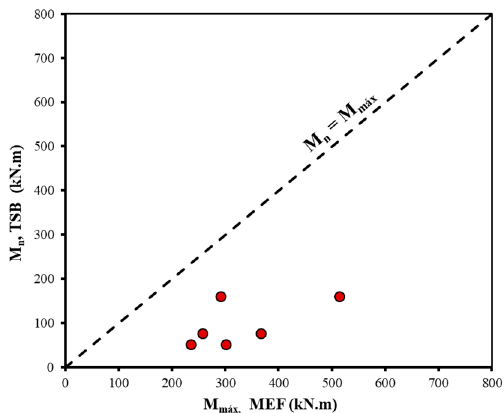
Figure 8. Comparison of FEM results with estimations of the triangular stress block (TSB) method.